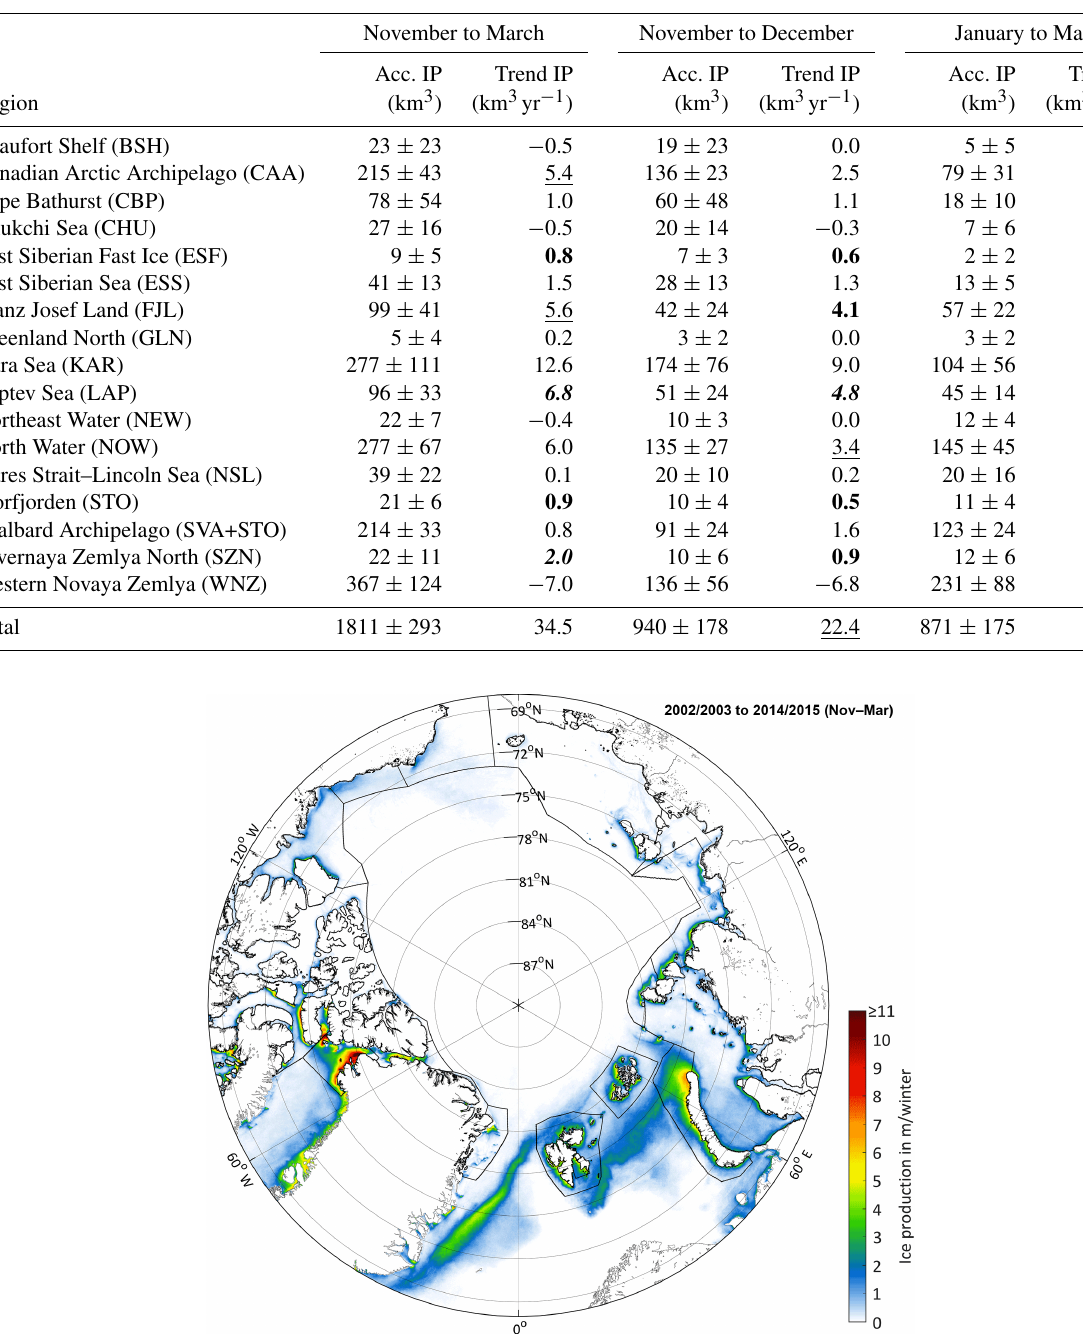
Table 3. Average accumulated ice production (IP) in km 3 in each polynya region between 2002/2003 and 2014/2015 (SFR cloud-cover correction applied). Aside from being based on the available winter period from November to March, it is further separated between the early freezing season (November to December) and the late freezing season (January to March). All values are derived from daily MODIS TIT composites after application of the predefined polynya masks (Fig. 1). Trends are additionally given, where underlined, bold and bold italic numbers denote statistical significance (two-sided t test) at the 90, 95 and 99% levels, respectively.